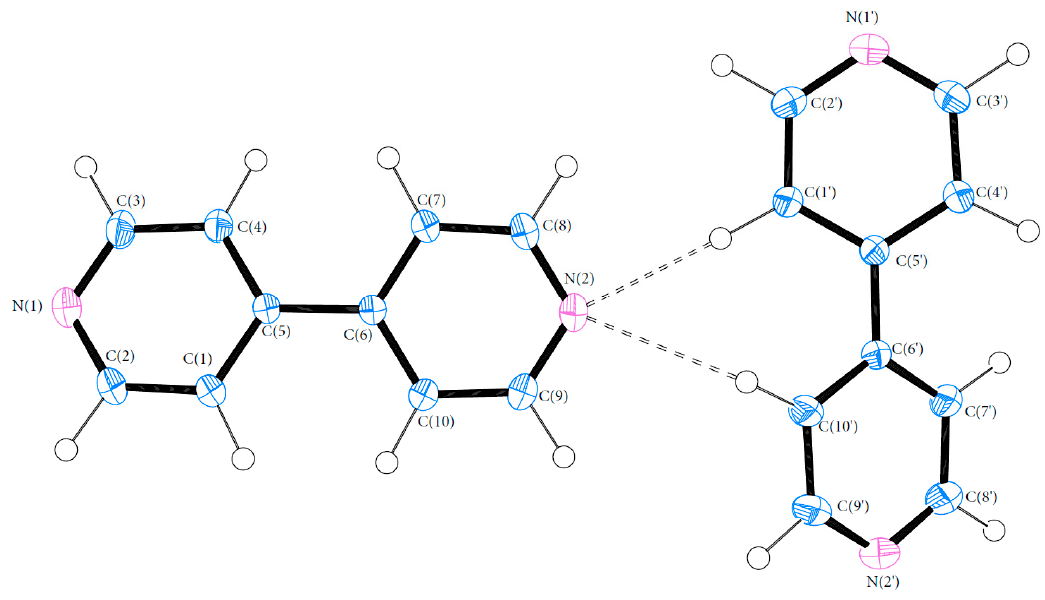
Crystals 2018 , 8 , 46 Figure 3. ORTEP diagram of 44BP ( 2 ). Thermal ellipsoids are shown at the 50% probability level [24].